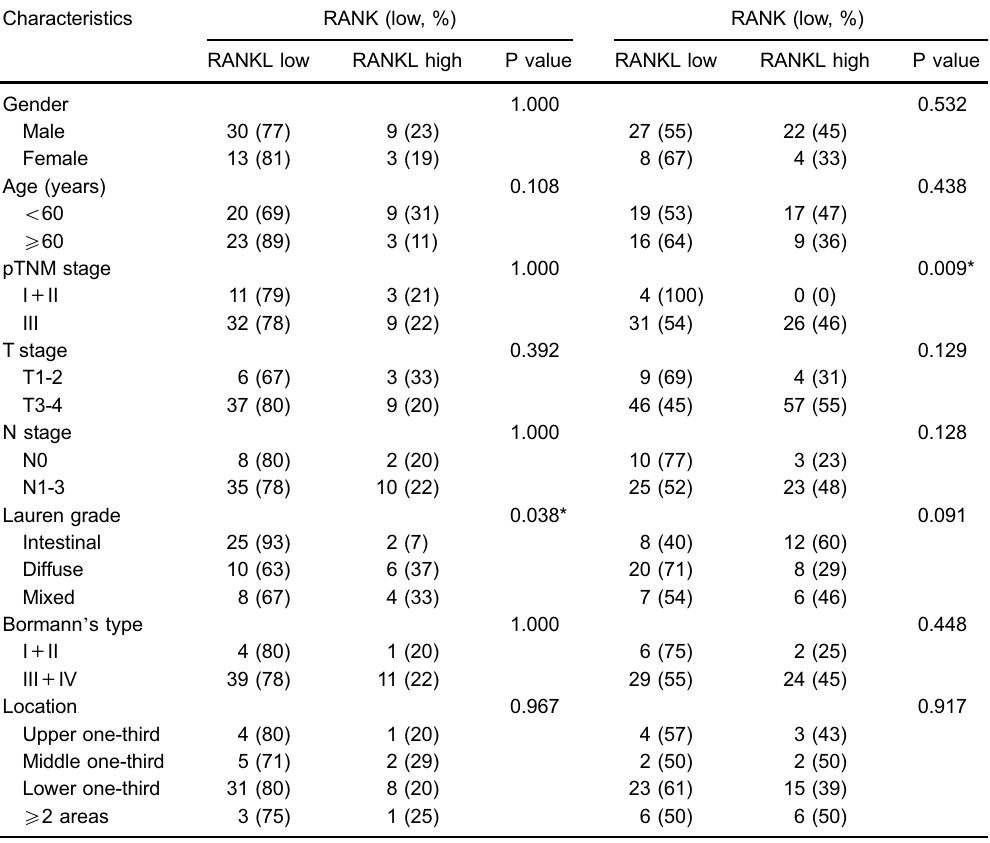
Table 4. Correlation between the expression of RANKL and the clinicopathological factors in patients with different RANK expression.